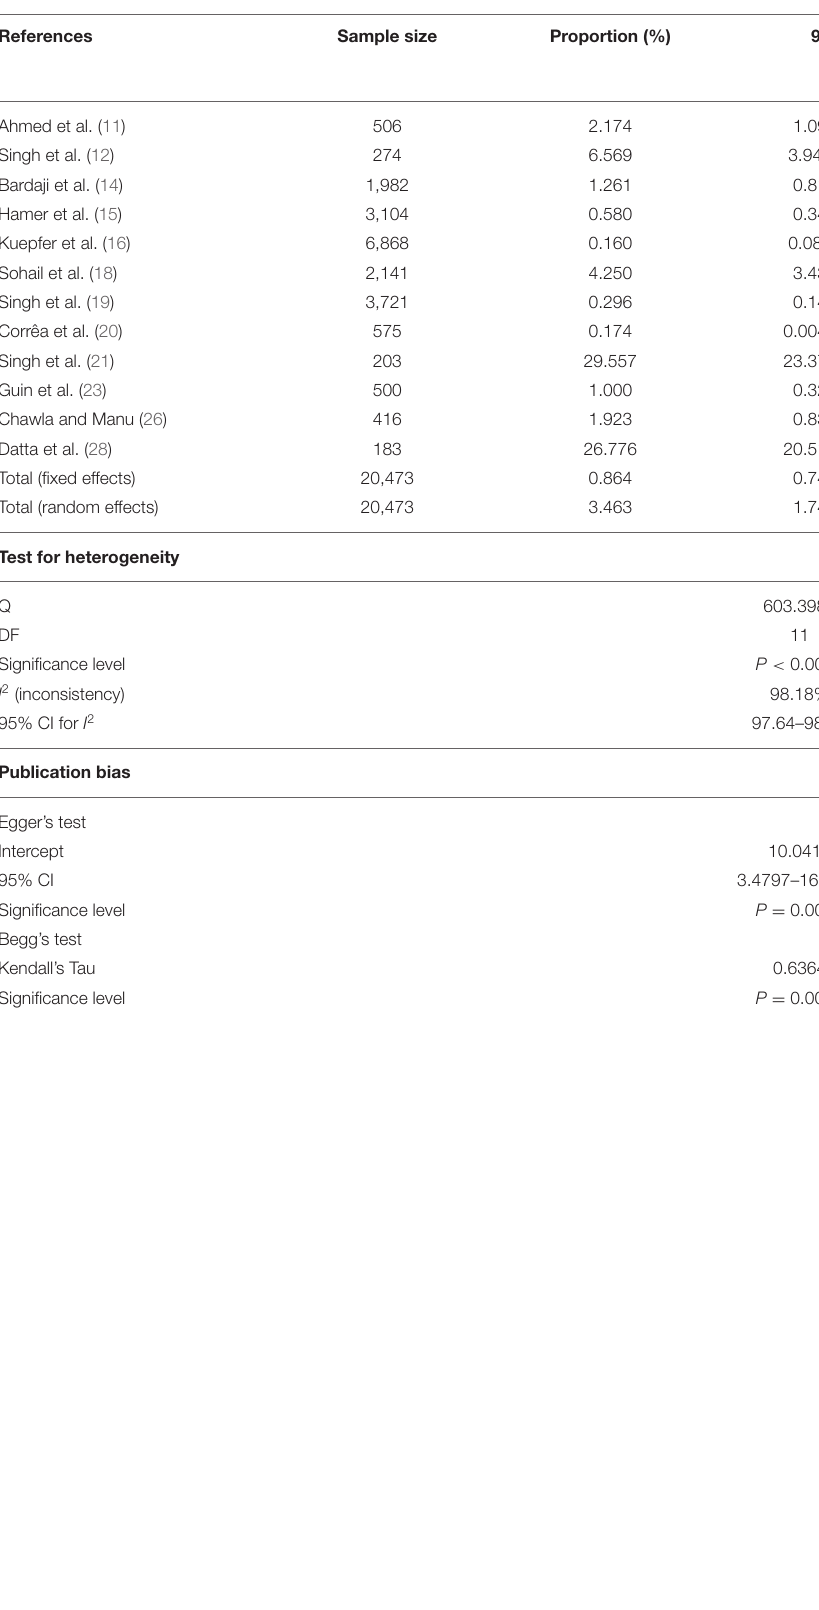
TABLE 9 | Pooled prevalence of Plasmodium vivax infection in pregnant